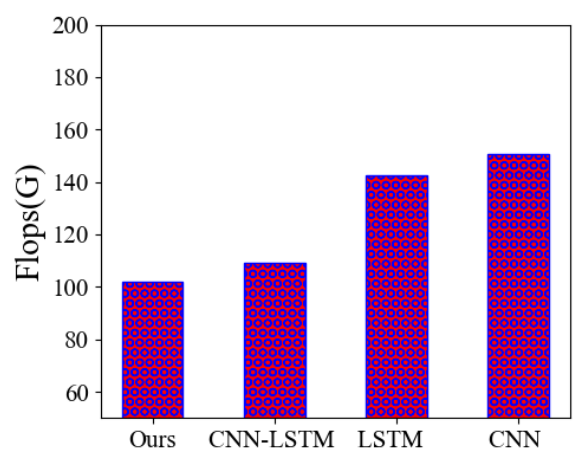
Figure 13. Comparing the amount of computation of different